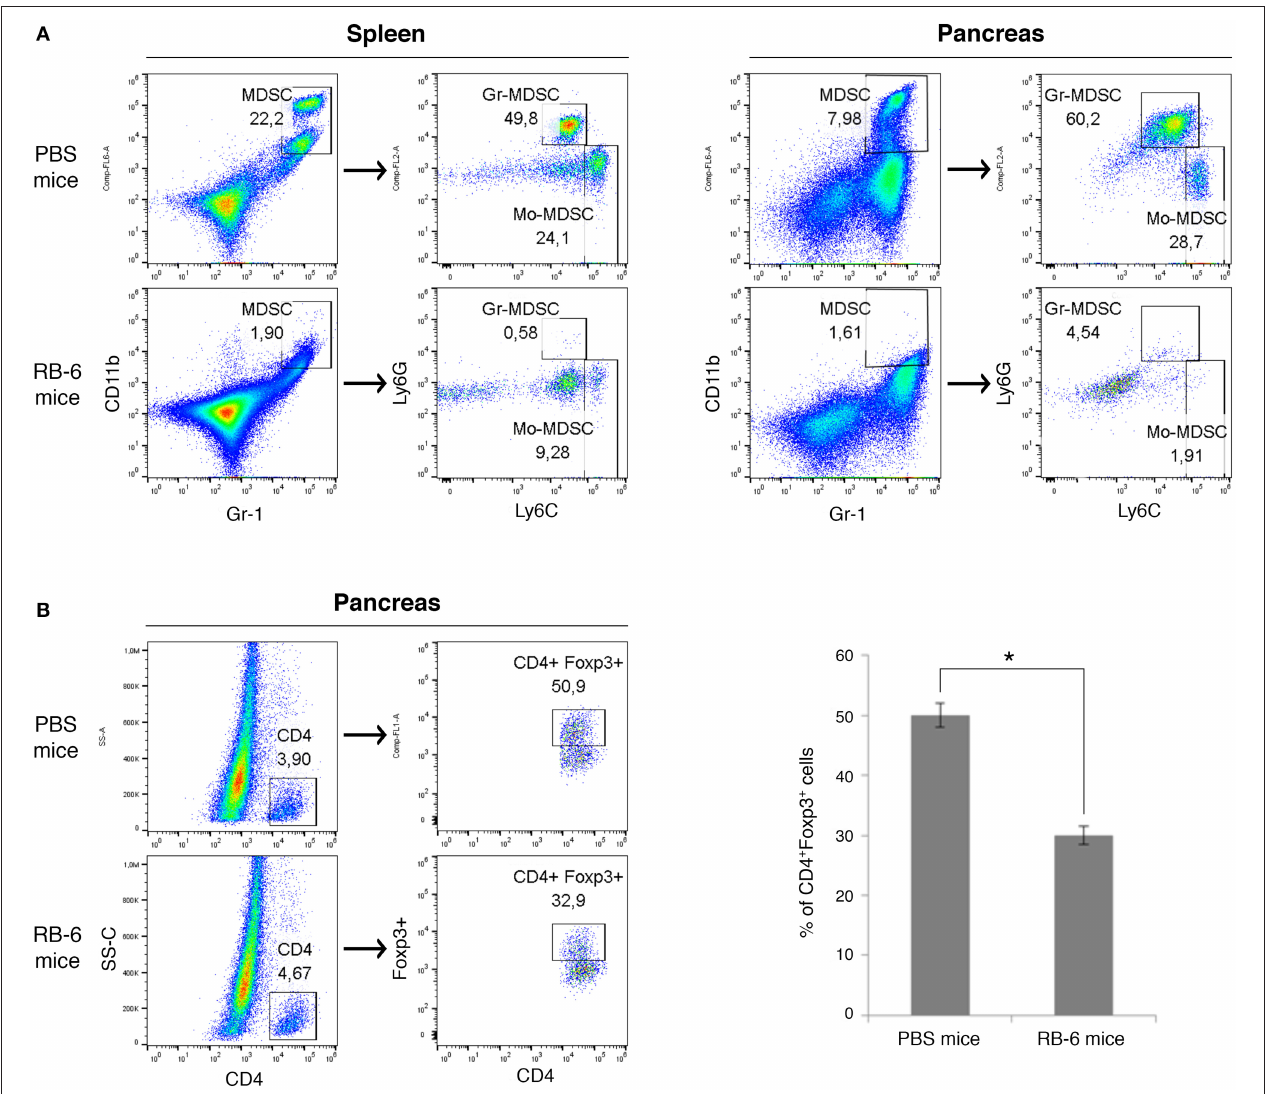
FIGURE 4 | Systemic depletion of MDSCs inhibits the recruitment of Foxp3 + Tregs in pancreatic tumors. Mice were injected with Panc02 tumor cells on day 0 and Gr-1 + cells were depleted on day 15 and 18 with intraperitoneal injection of anti-RB6 antibody (RB-6 mice). Control mice received injection of PBS (PBS mice) or isotype control antibody. Spleens and tumors were harvested 3 weeks after PDAC induction. The percentage of splenic and pancreatic MDSCs (CD11b + Gr-1 + ), MDSC sub-populations (A) and Treg cells (CD4 + Foxp3 + ) (B) was evaluated by flow cytometry. Percentage of positive cells are shown. The results represent one of three independent experiments with similar data, * p <